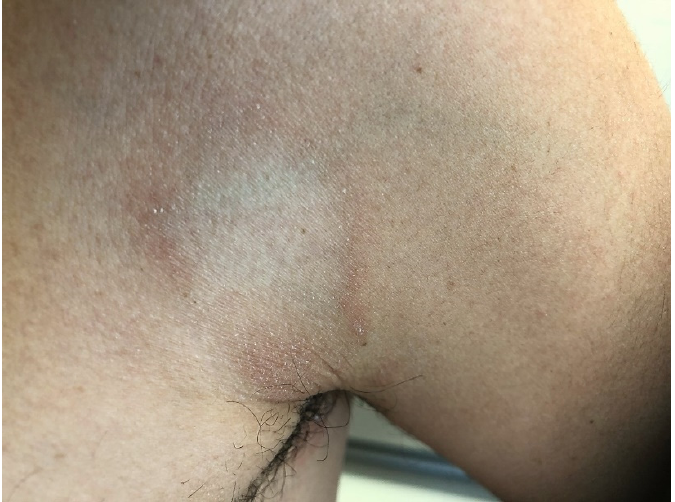
Figure 3. Late lesion is characterized by a complete ring of hyperpigmentation on the axilla.